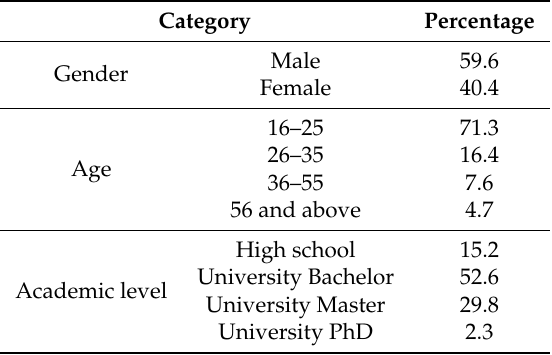
Table 3. Demographic